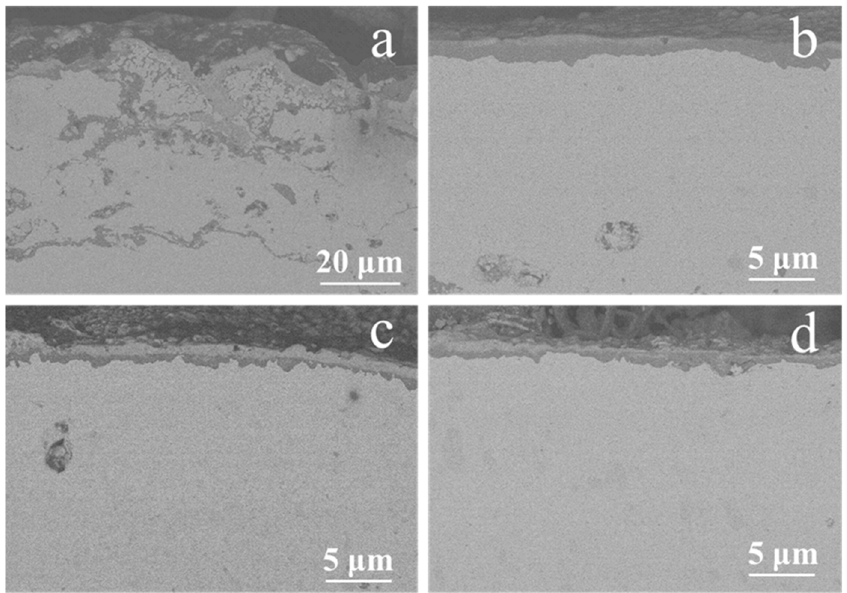
Figure 6. Sectional SEM backscattering images of the NiCrAlY coating before and after a high- current pulsed electron beam irradiation with static oxidation at 900 ◦ C for 200 h: ( a )